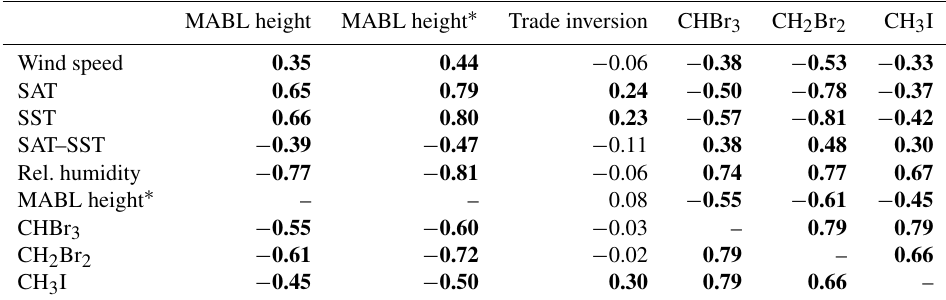
Table 2. Spearman correlation coefficients ( R ) of meteorological parameters, MABL height and trade inversion height correlated with atmospheric bromoform (CHBr 3 ) , dibromomethane (CH 2 Br 2 ) and methyl iodide (CH 3 I). MABL height ∗ is the determined MABL height from the radiosonde launches, complemented by the regressed MABL height (Sect. 3.3). Bold coefficients are significant with a p value of <